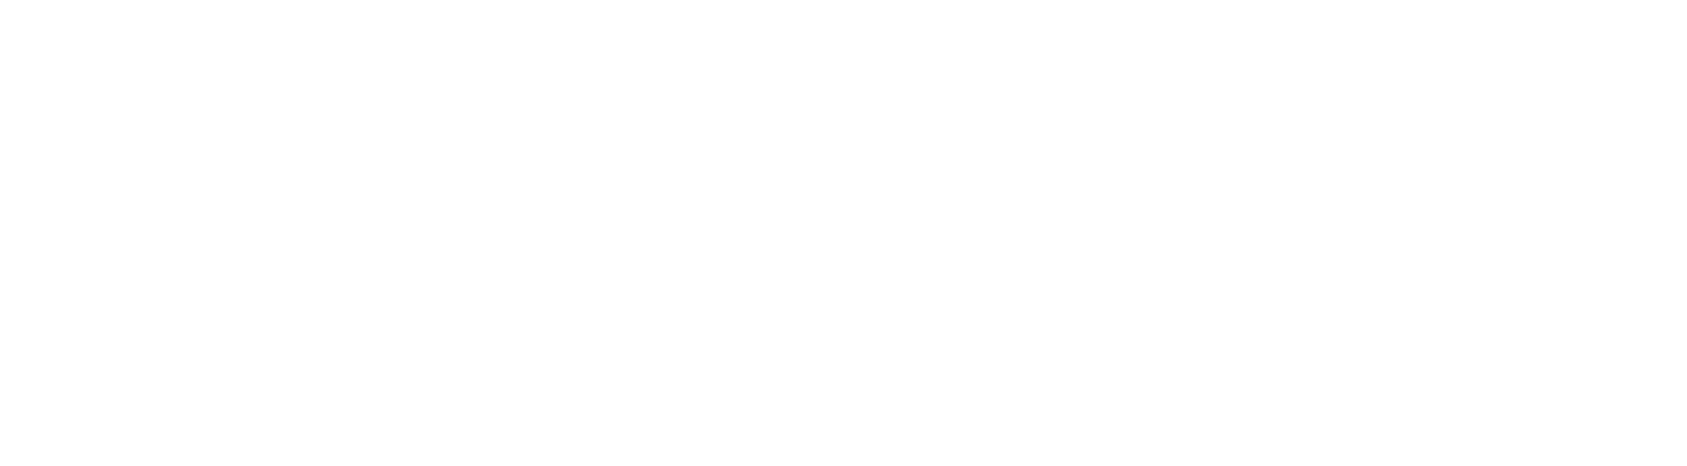
FIGURE 5 | RAG regulators page where (A) shows a table with the expression values RAG1 interacting partners in B cell stages along with the corresponding heatmap in (B)